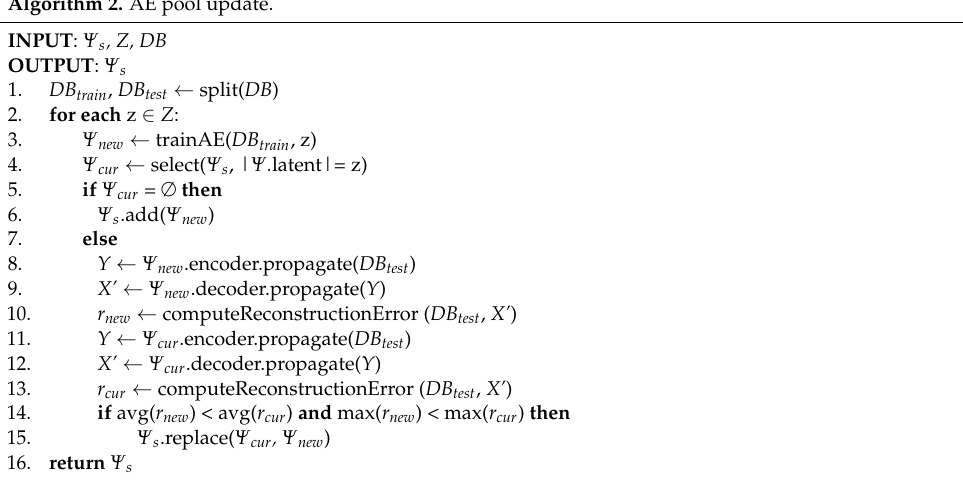
Algorithm 2. AE pool